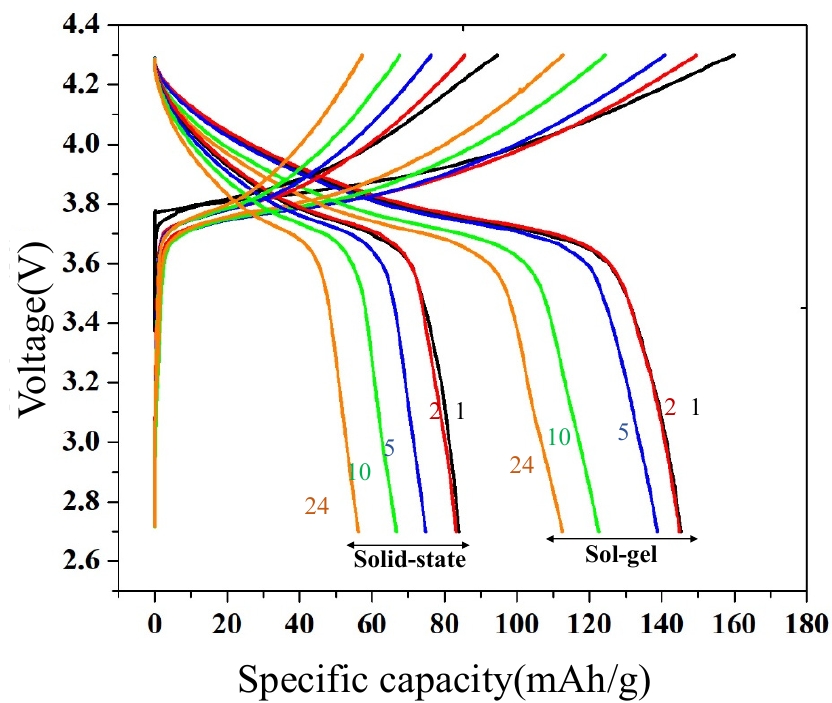
Figure 5. Electrochemical performance of layered LiNi 0.5 Mn 0.5 O 2 . First—fifth charge discharge voltage profile examines at 2.7-4.3 V under 0.05 C for sol-gel and solid-state samples.